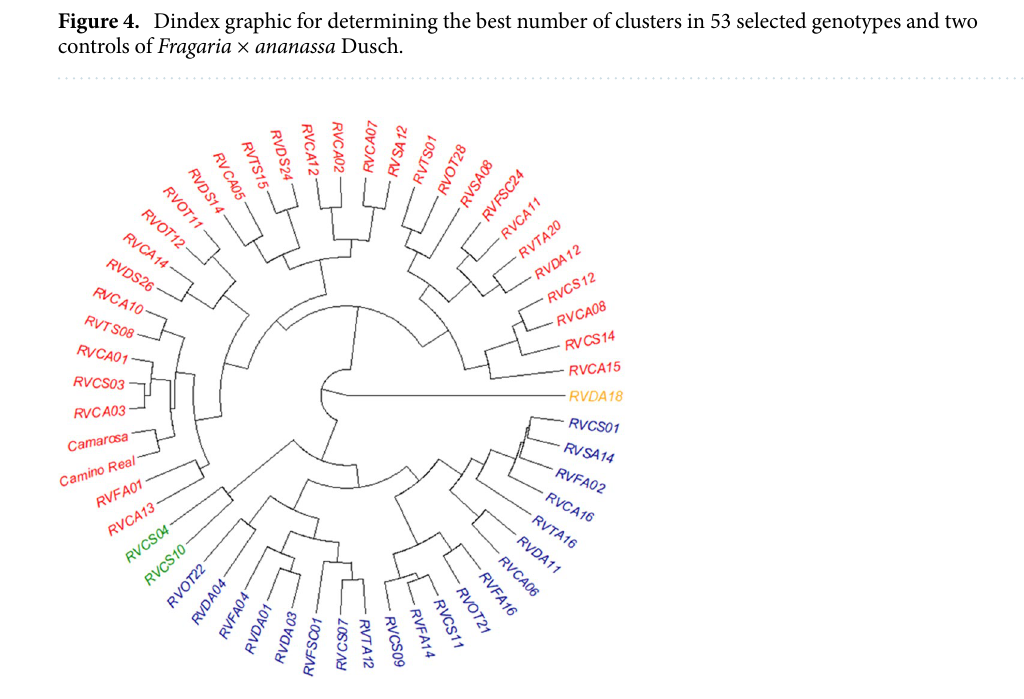
Figure 5. Circular dendrogram based on yield and biochemical traits of the 53 selected genotypes and two controls of Fragaria × ananassa